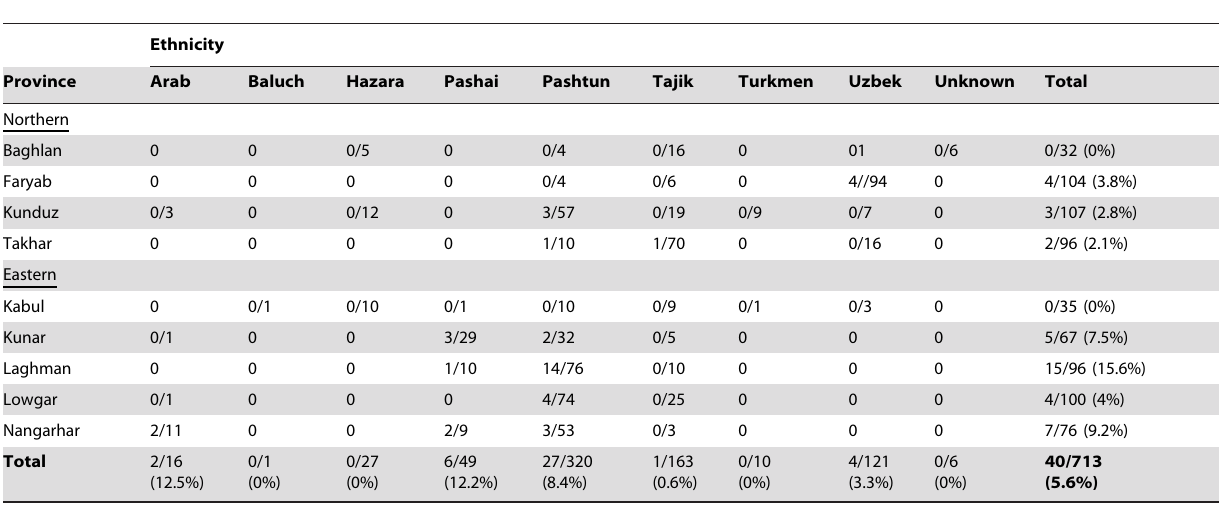
Table 2. Number of individuals with the 563C . T mutation among 713 male individuals studied.